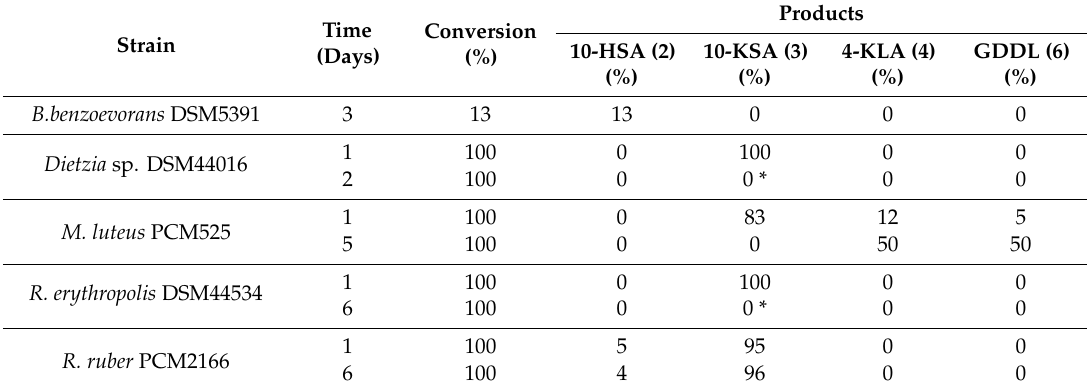
Table 1. Composition of the biotransformation mixture given in % according to GC–MS analysis.